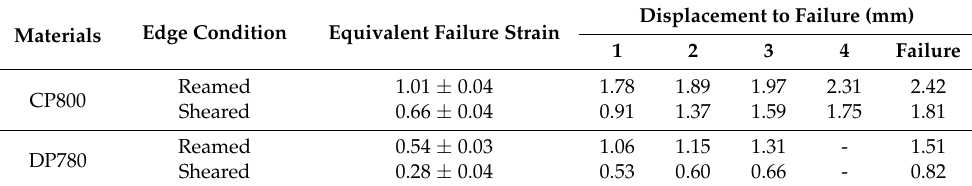
Table 3. Equivalent failure strain and displacement to failure for the reamed and sheared holes of the CP800 and DP780 steels during the hole tension test.